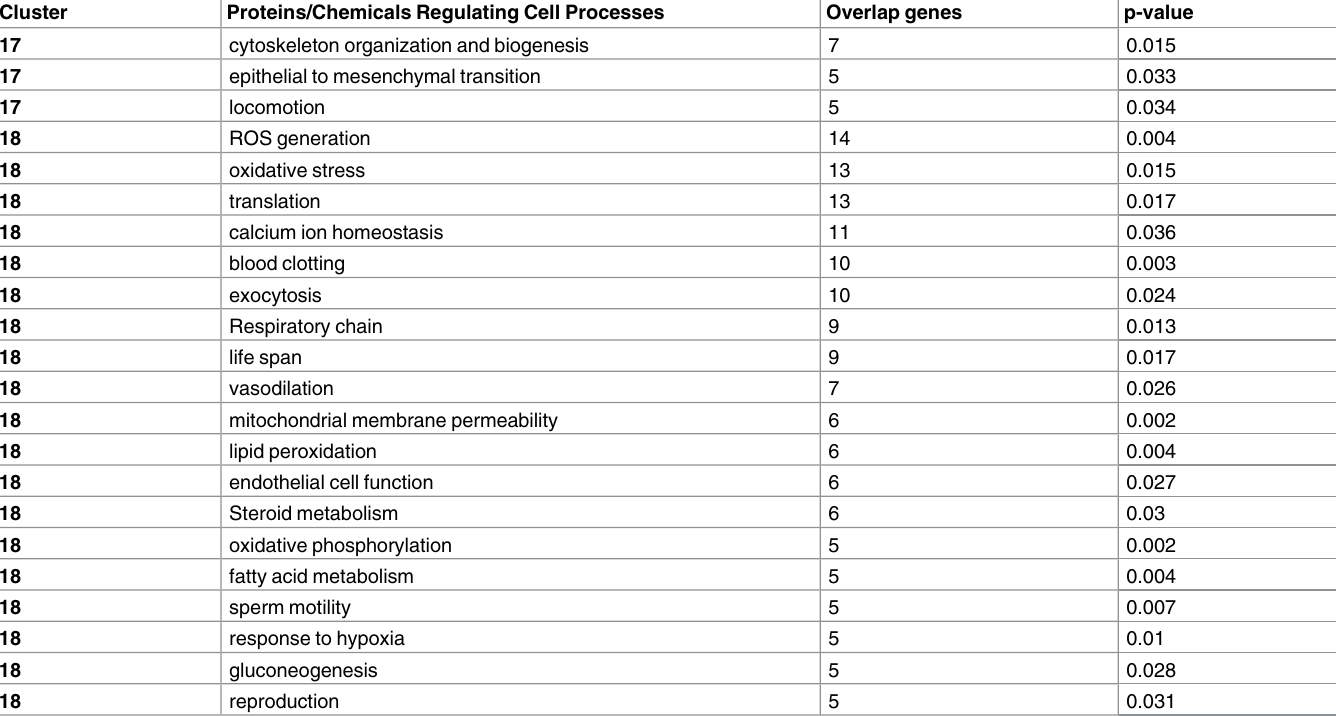
change; p (cid:20) 0.001). GSEA revealed several cell processes that changed over the reproductive cycle. Fig 8 shows that processes related with phagocytosis increased after the spawning season